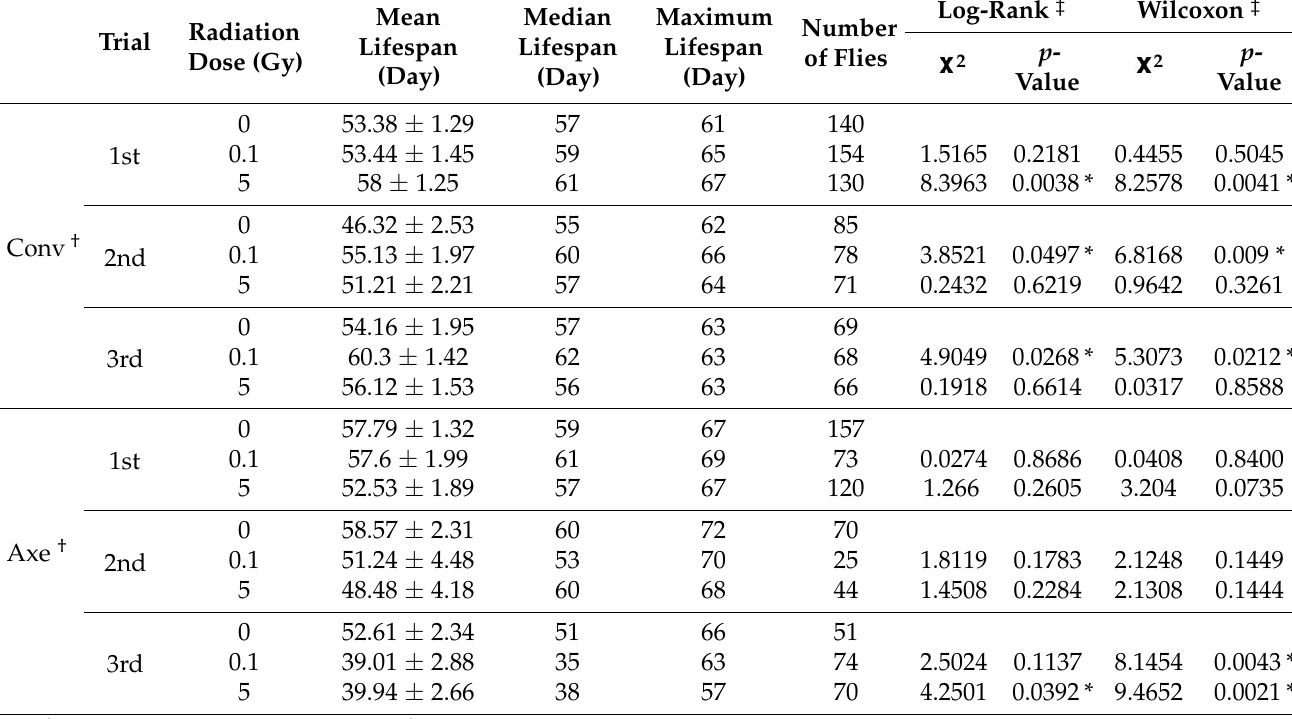
Table 2. Lifespan of the Conv and Axe flies after γ -ray irradiation at the third instar larval stage.